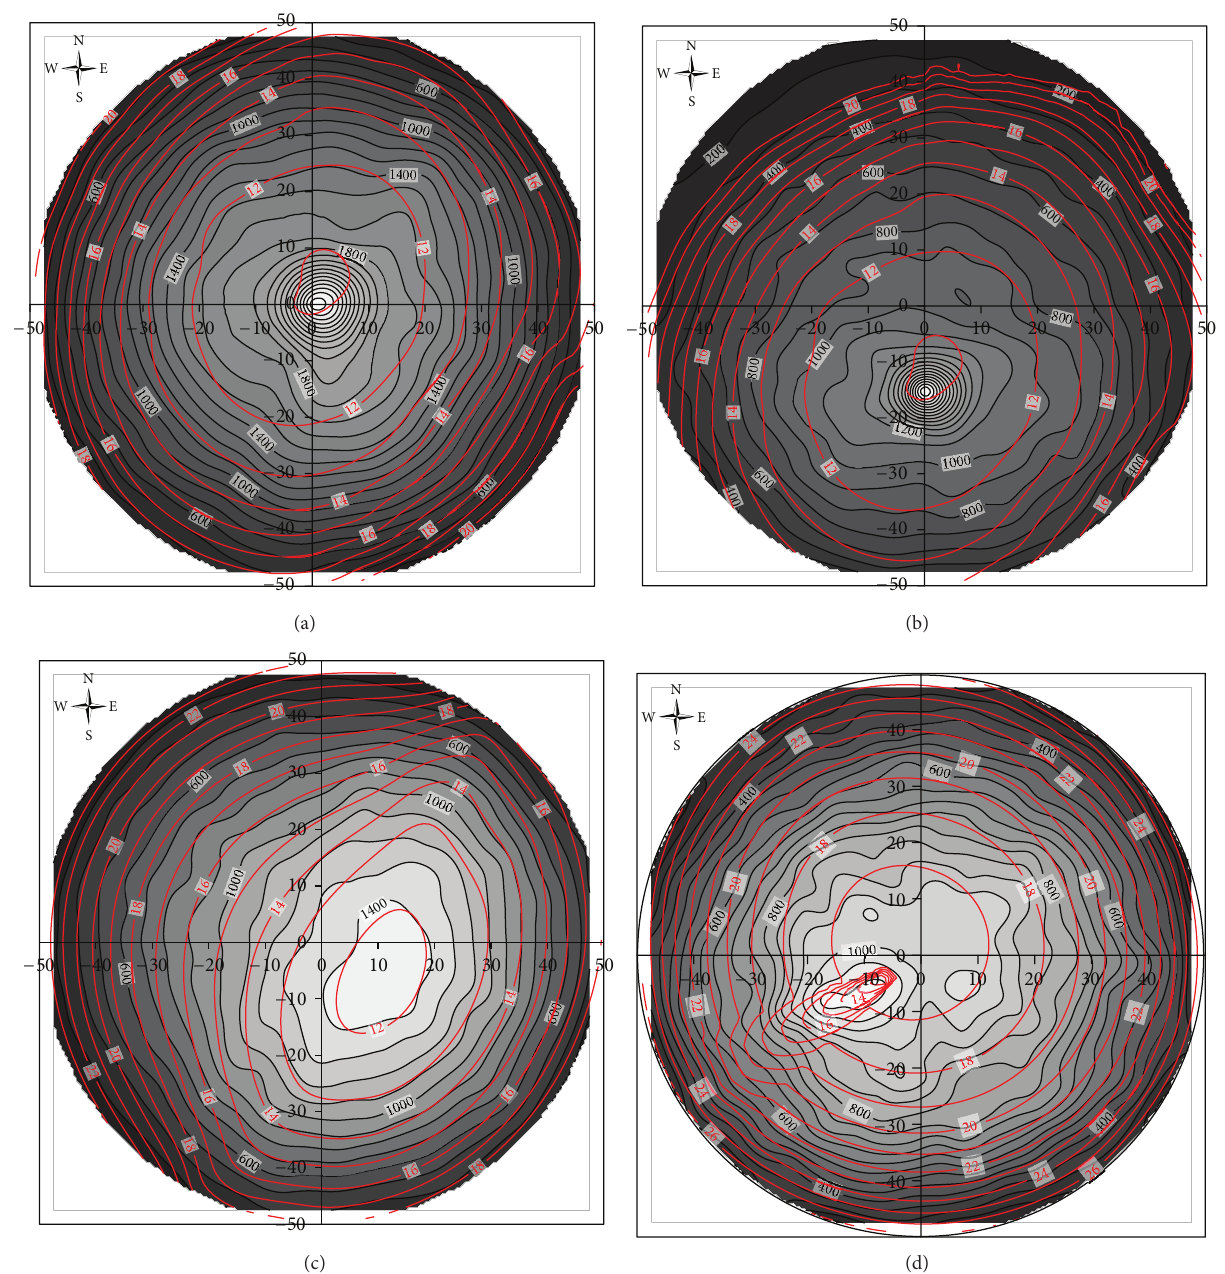
Figure 5: Measurements taken at K˝ob´anya at different places of the artificial tunnel. Upper row : Detector was exactly under the axis of the blow hole (a), 15 ∘ tilted detector at the same position (b), next to the wall of the tunnel (c), and the shifted detector position (d). Solid red lines are for the rock’s length to the given direction in angles; shading is for the muon distribution after geometrical correction.